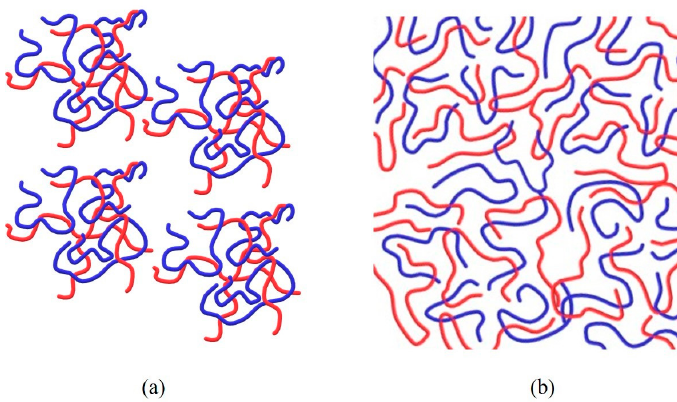
Figure 6. Sketch of PEC’s macromolecular microstructure (a) in water and (b) in water/ethanol co-solvent. PAH— , PAA— .